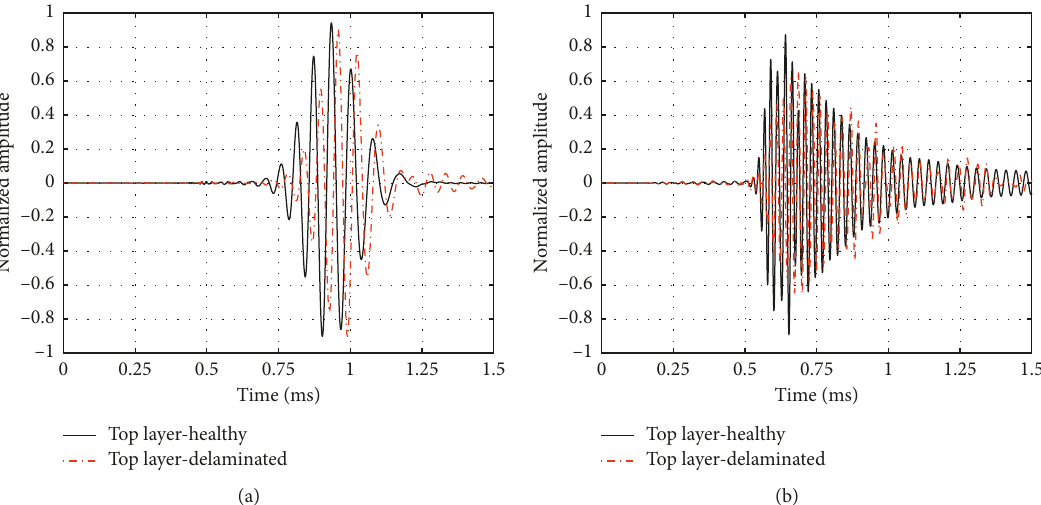
Figure 8: Response of the system in the time domain for both healthy and delaminated plates for excitation frequencies of (a) 15kHz and (b) 40 kHz at a measurement node after the debonded region.